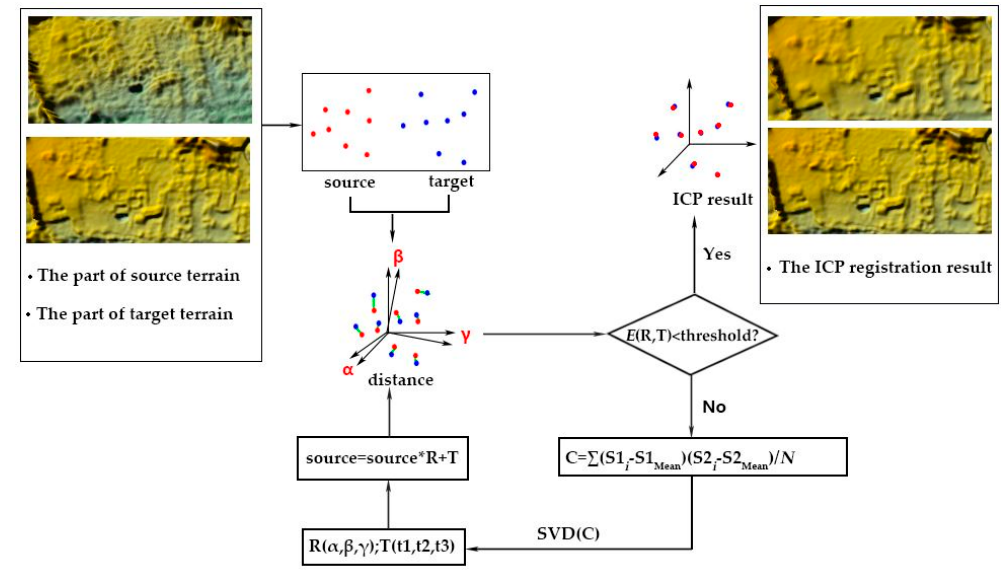
Figure 1. Schematic of the principle and workflow of the iterative closest point (ICP) algorithm. A given surface can be described as a point